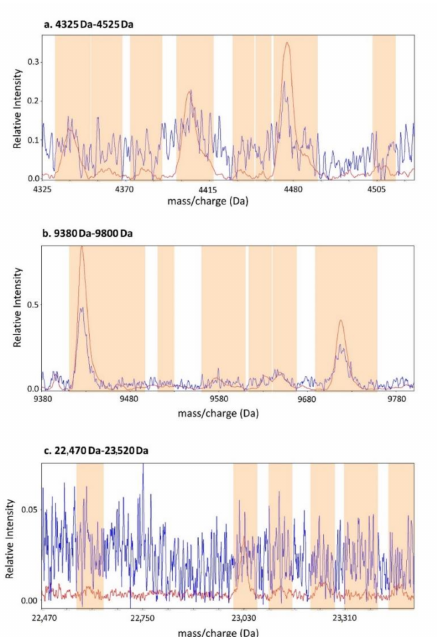
Figure 5. Comparison of a conventional MALDI spectrum with a Deep MALDI spectrum. A 2400-shot conventional spectrum (blue) and a 400,000-shot Deep MALDI spectrum (red) for a sample in the development cohort are shown for three regions of the mass spectrum: ( a ) 4325–4535 Da, ( b ) 9380–9800 Da, and ( c ) 22,470–23,520 Da. The orange bands show the locations of mass-spectral